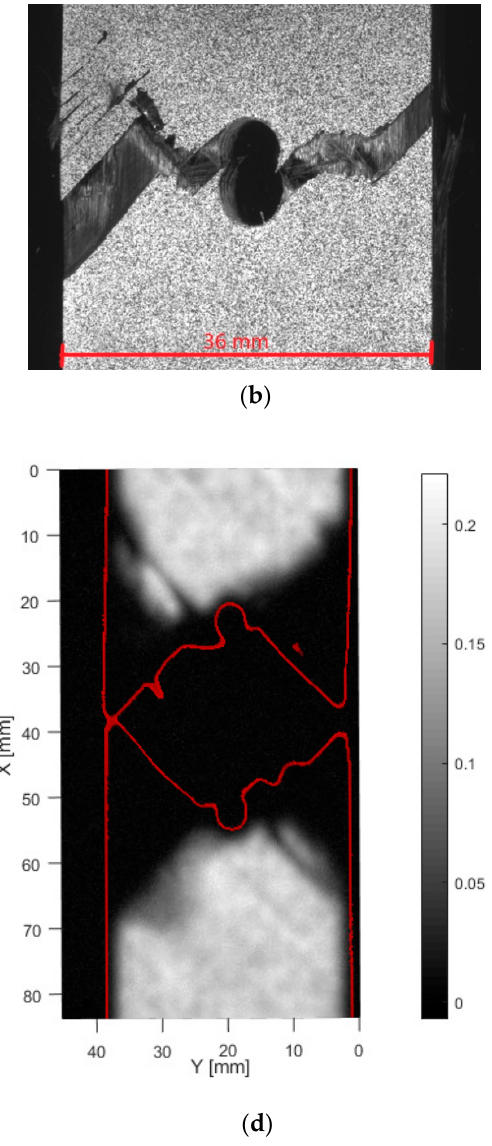
Figure 9. Tensile failure of [+45/0/ − 45/90] 3s , ( a ) front view just before failure, ( b ) front view after failure ( c ) side microscopy, ( d ) through transmission ultrasound (for high resolution, please refer to the online version of this article) .